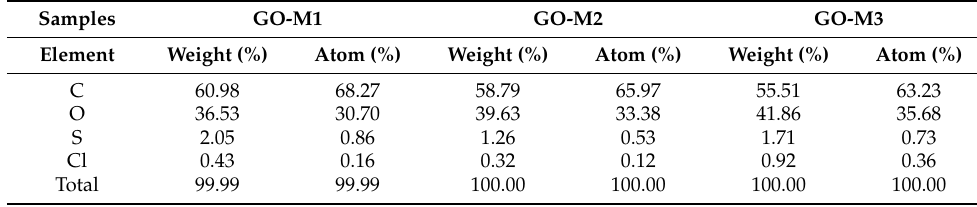
Table 1. EDS element semi-quantitative analysis results of three types of GOs.